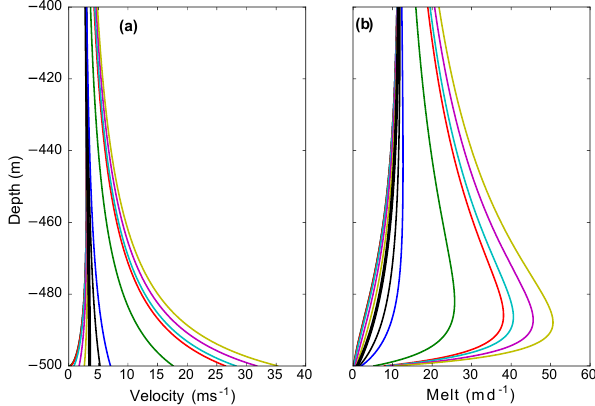
Figure 2. Different runs of the CP model for different initial ve- locities. Panel (a) depicts the velocity profile in the first 100m. All initial velocities converge within 100m to the trajectory of the bal- ance velocity U (cid:63) 0 = 3 . 5ms − 1 (thick black line). The correspond- ing initial radii differ thus from 300m (for U 0 = 3 . 5 × 10 − 3 ms − 1 ) to 3m (for U 0 = 35ms − 1 ). Panel (b) shows the corresponding melt profile. Higher initial velocities give a maximal melt rates at deeper levels. All melt rate profiles converge to the same melt rate after a certain